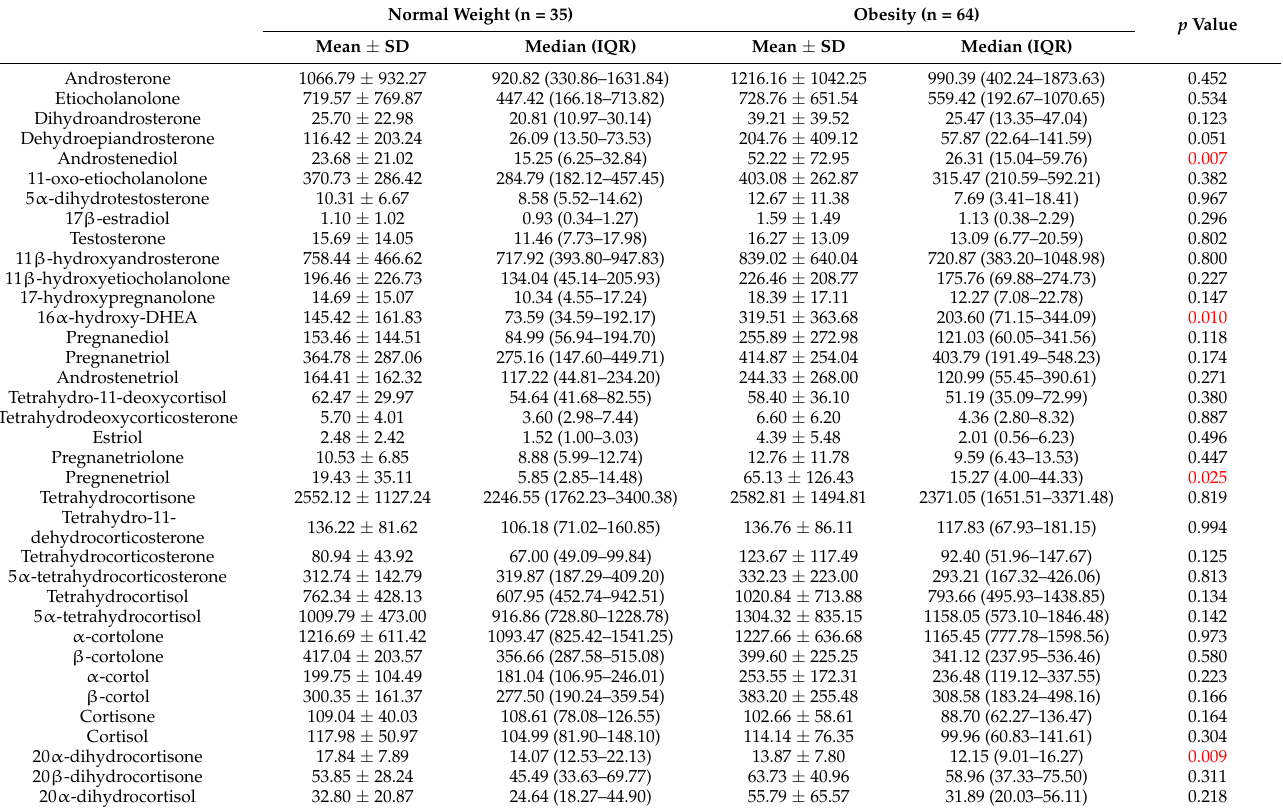
Table 4. List of steroid metabolites ( µ g/24 h): differences between the normal weight and obesity in